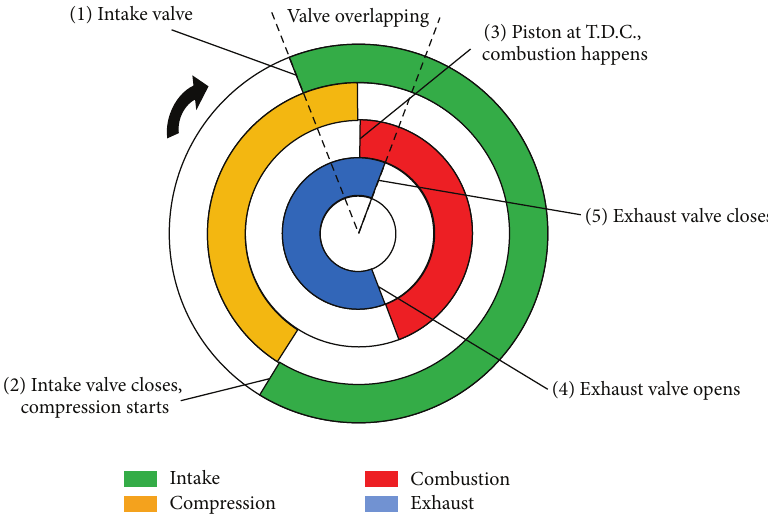
Figure 2: Valve overlapping in term of piston